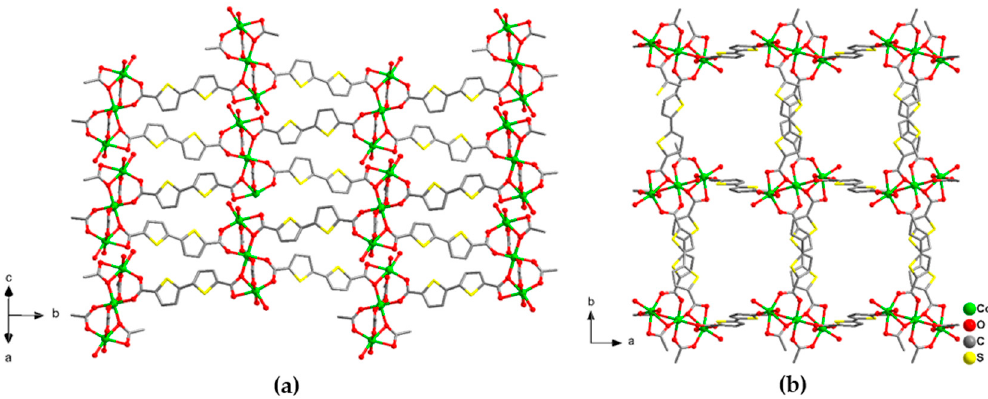
Figure 4. Projection of the crystal structure of 3 along with different directions ( a , b ). Cobalt atoms are shown by green balls. Only O atoms of coordinated dmf ligands are shown. Hydrogen atoms and guest solvent molecules are omitted .